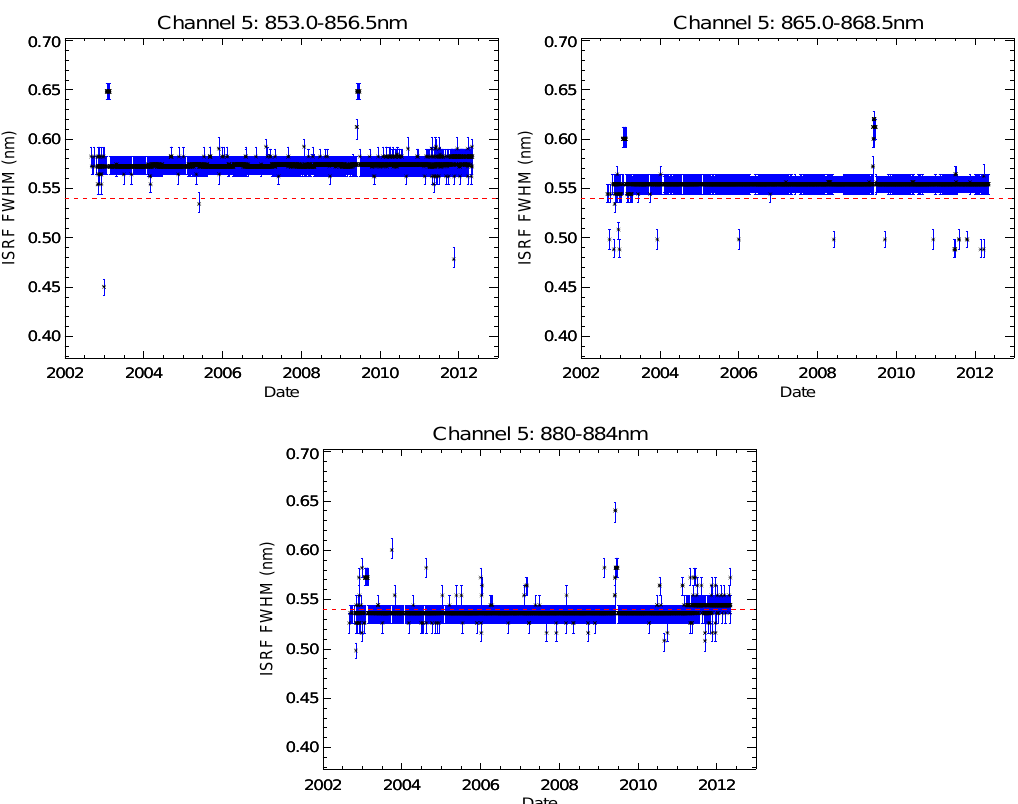
Figure 15. Similar to Figure 11 but for Channel 5. The three plots correspond to the three spectral lines from Table